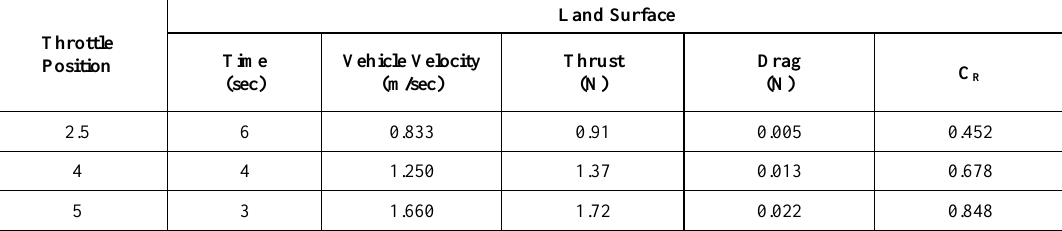
Table 5. Performance of hovercraft in